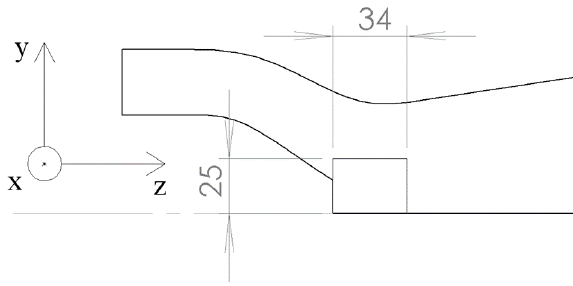
Fig. 9. Region for strain rate tensor computation